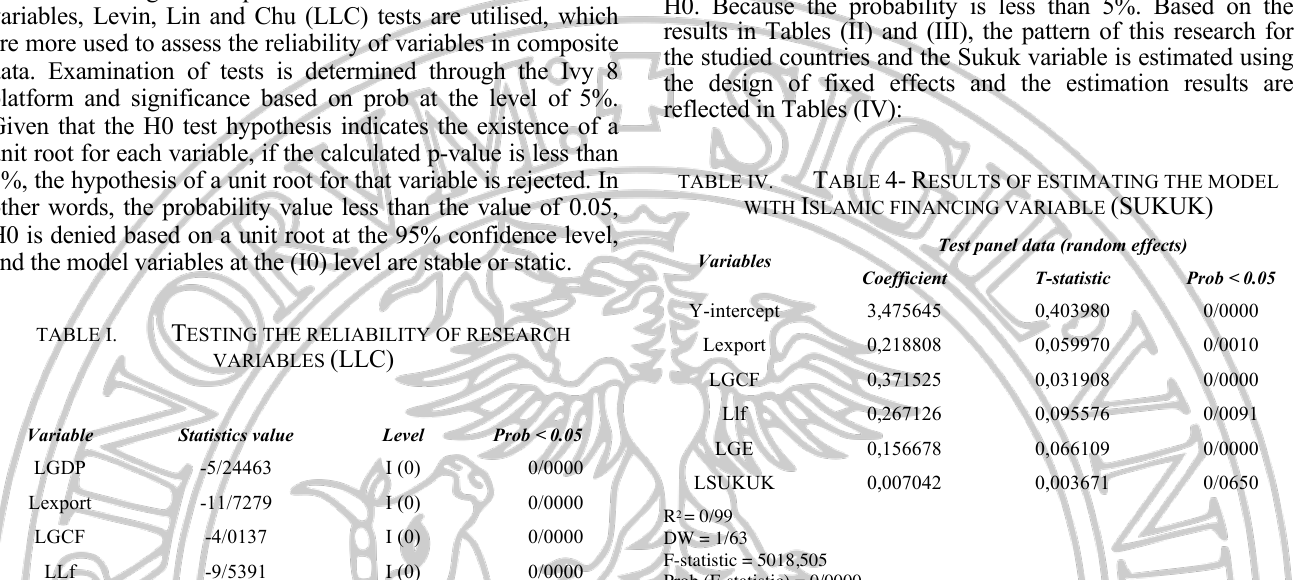
T ABLE 4- R ESULTS OF ESTIMATING THE MODEL WITH I SLAMIC FINANCING VARIABLE